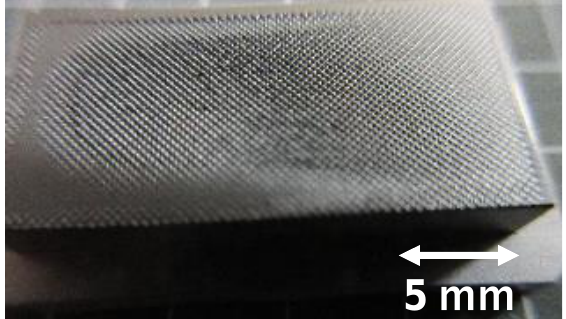
Figure 8. Multi-punch array formed on the surface of AISI316 die by sand blasting for 300 s.